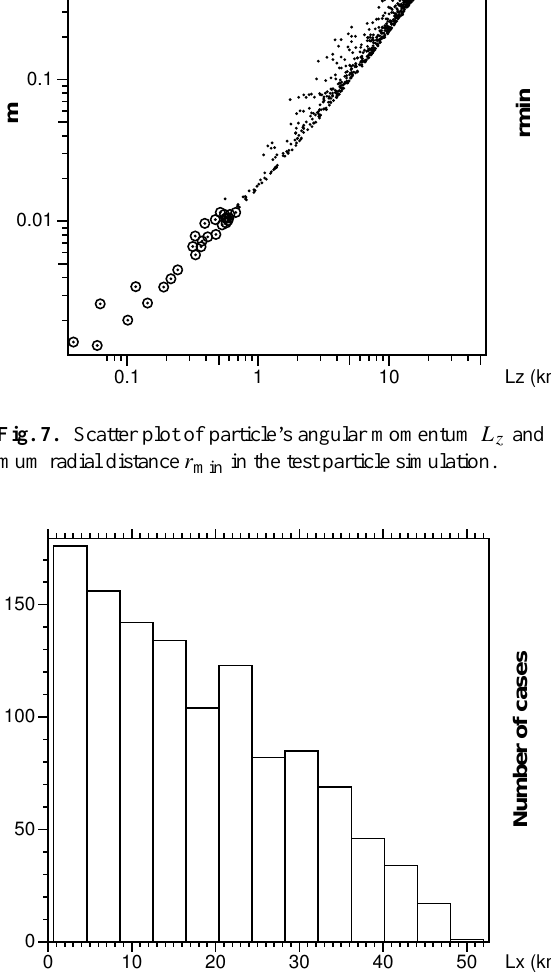
Fig. 8. Distribution of electron’s angular momentum L z in the test particle simulation.